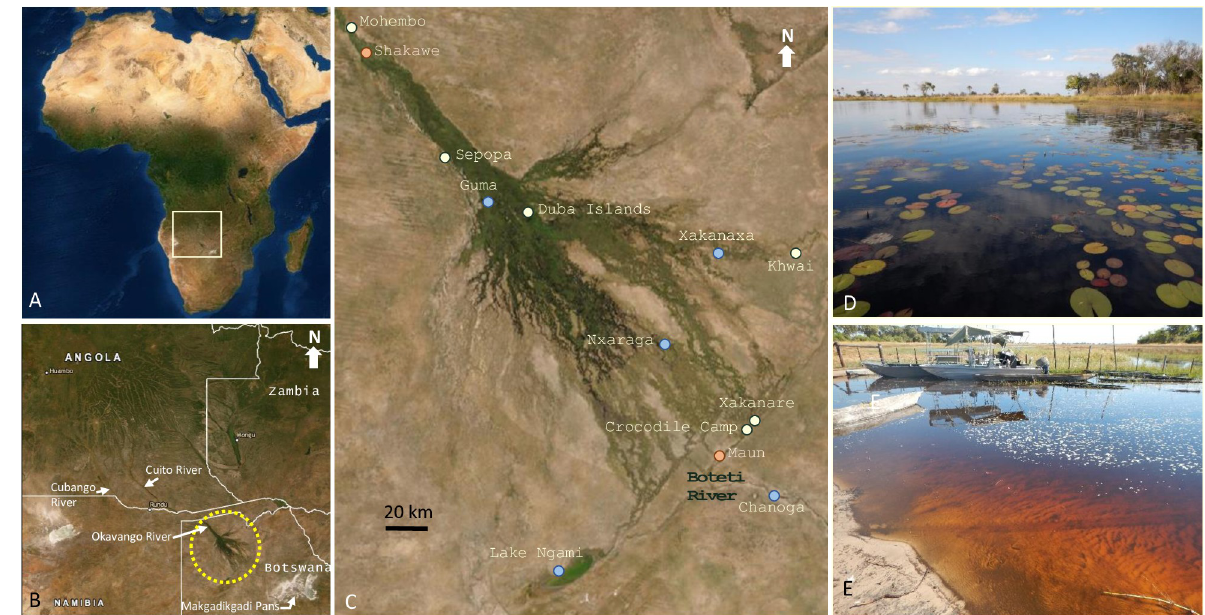
Fig 1. Geography and character of the Okavango Delta. Map of Africa (A) with rectangle that is enlarged in (B) to show the Okavango watershed with major rivers in Angola, Namibia, and Botswana; the yellow dotted circle indicates the Okavango Delta and the bent white arrow shows the Makgadikgadi Pans. Field sites within the Okavango Delta (C) include fish sampling sites shown in blue, major towns in orange, and water quality monitoring sites in yellow and blue; oxygen dataloggers were located at Guma). The Okavango is a vast wetland characterized by exceptional water quality and biodiversity (D). Annual flood arrival is marked by a dramatic increase in dissolved tannins that change the water from clear to tea- colored (E). Photo Credits: TME. Open source map base: https://landlook.usgs.gov/.